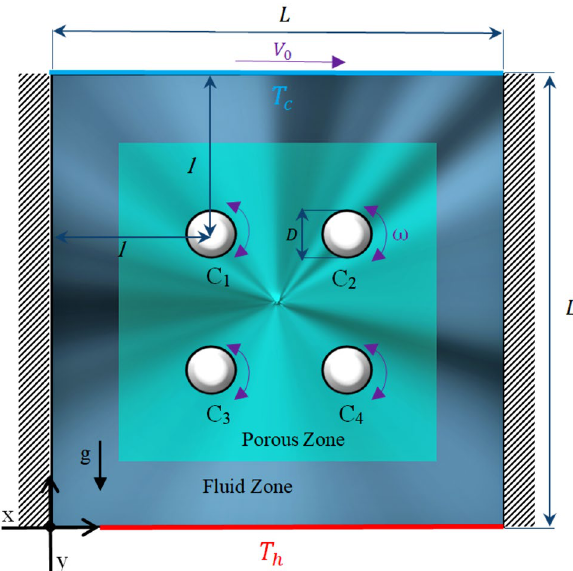
Figure 1. Schematic of the physical model.